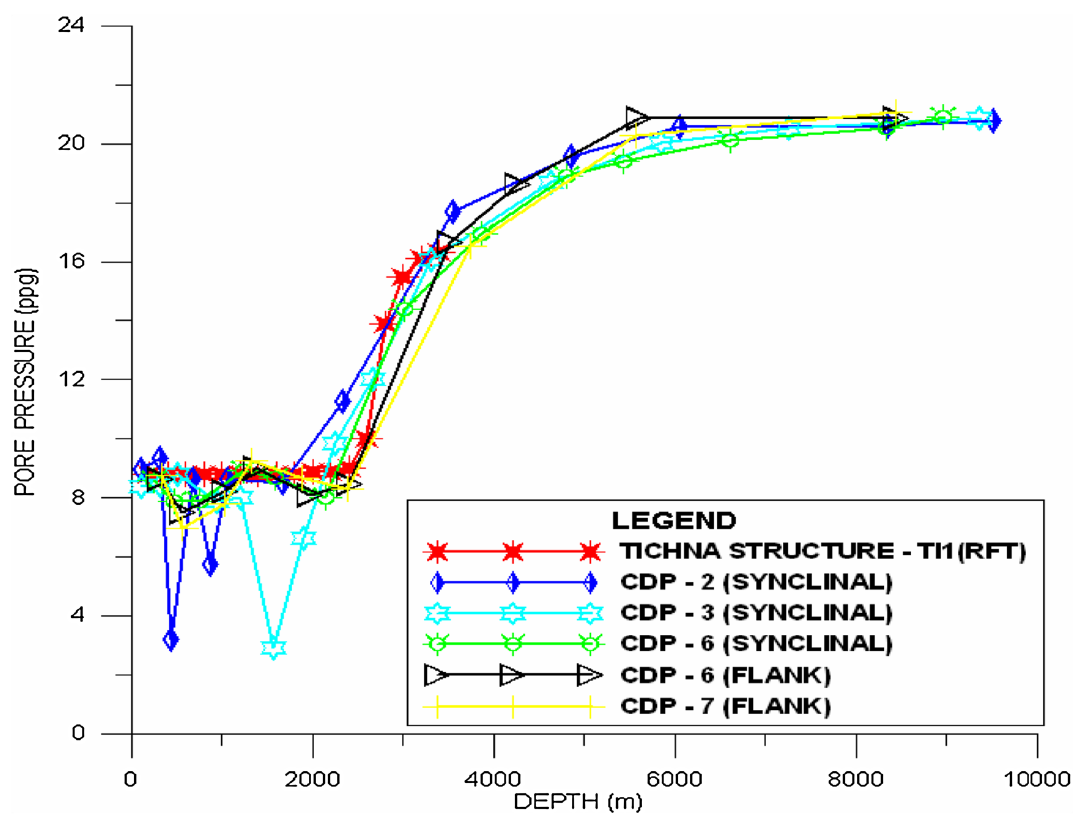
Fig. 7 Tichna structure—TI1-measured pore pressures vs predicted pore pressures (Reproduced with permission from Brahma 2013)